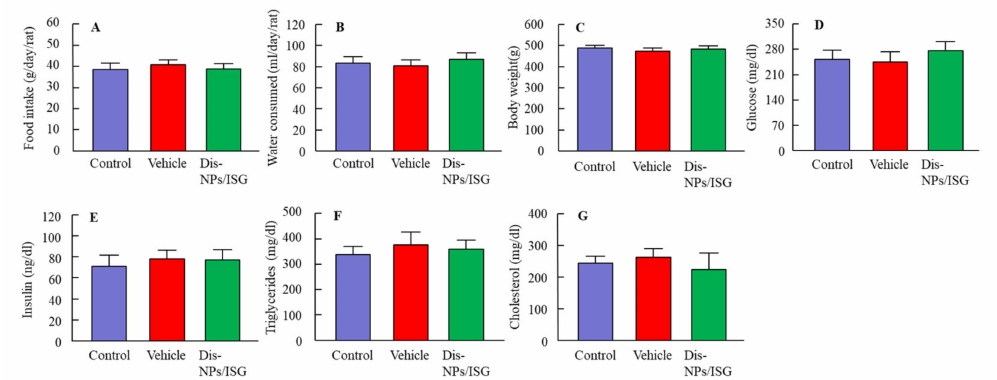
Figure 5. E ff ect of the Dis-NPs / ISG on food ( A ) and water ( B ) intake, body weight ( C ), plasma glucose ( D ), plasma insulin ( E ), plasma triglycerides ( F ), and plasma cholesterol ( G ) levels in the 15-month-old Otsuka Long–Evans Tokushima Fatty (OLETF) rats. The Dis-NPs / ISG was repeatedly instilled into the right eye of OLETF rats for 1 month (twice a day, 9:00 a.m. and 7:00 p.m.). Control, noninstilled OLETF rat; Vehicle, vehicle-instilled OLETF rat; Dis-NPs / ISG, Dis-NPs / ISG-instilled OLETF rat. n = 5–6. The repetitive instillation of Dis-NPs / ISG did not a ff ect the food and water intake and some blood test values for diabetes mellitus (DM) in the OLETF rats.